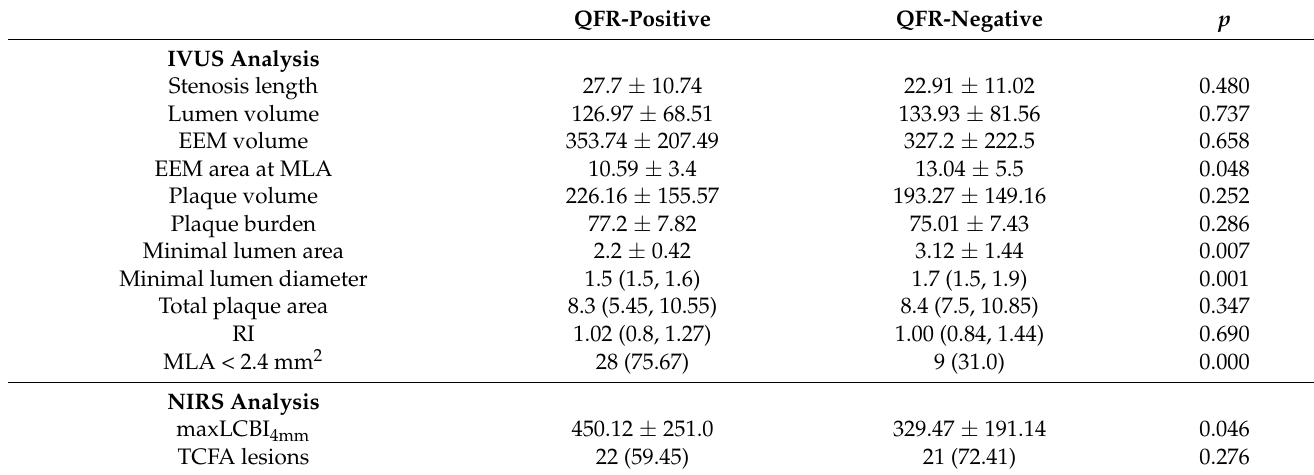
Table 2: Variables are displayed as mean ± SD when a normal distribution is present or as median (1st–3rd quartile) when there a normal distribution is not present. For each variable, the percentage of patients involved ( n %) is given. ACS—acute coronary syndrome; Cx—circumflex coronary artery; EEM—external elastic membrane; LAD—left anterior descending; maxLCBI 4mm —maximal lipid core burden index in 4 mm; MLA—minimal lumen area; RI—remodeling index; RCA—right coronary artery; TCFA—predicted thin cap fibrous atheroma by NIRS.